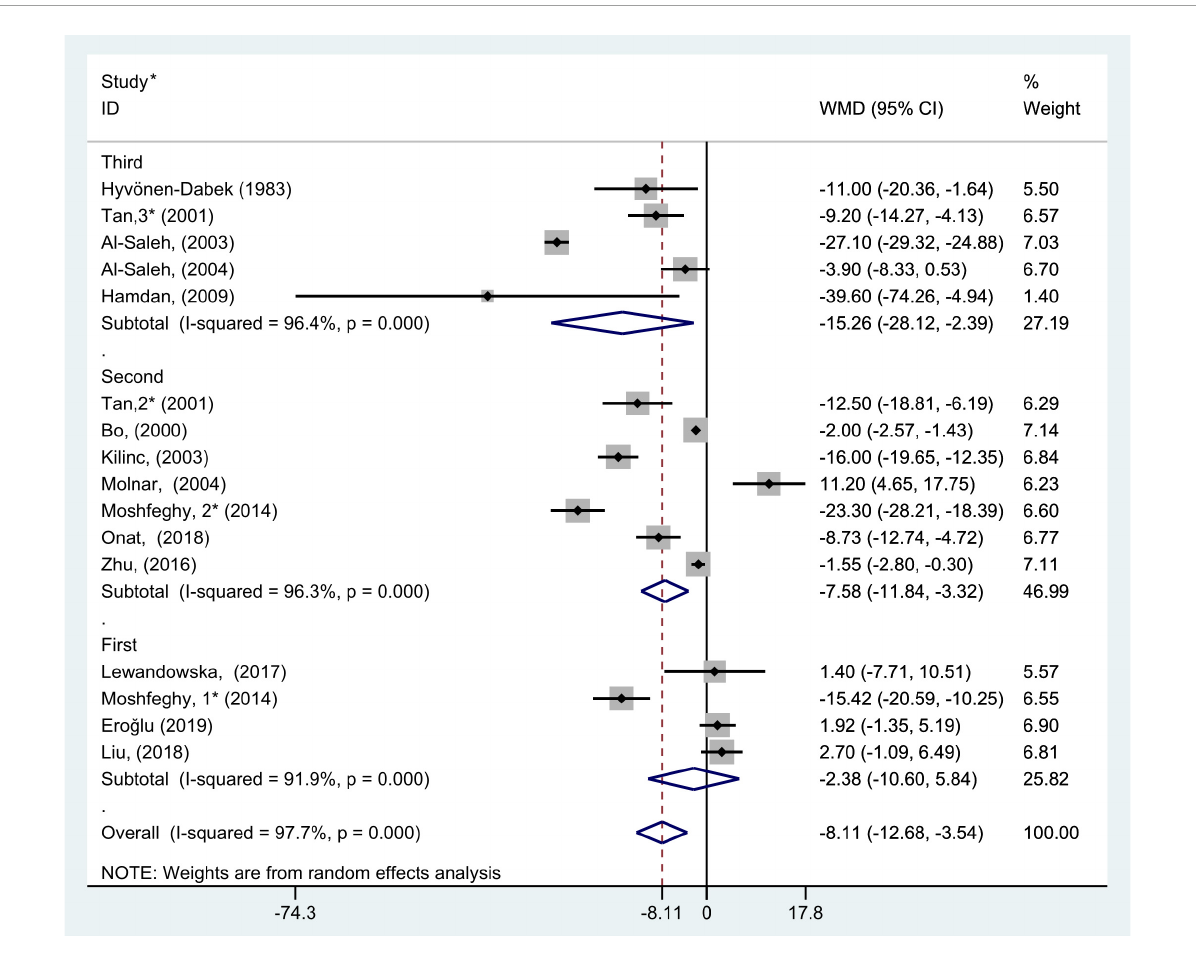
FIGURE4 Subgroup analysis of blood selenium level in patients with gestational diabetes mellitus and healthy pregnant women based on different trimesters. The random effects model is applied. For studies in which blood selenium levels were measured during different pregnancy periods in one study, 1, 2, and 3 are used to denote measurements performed in the first, second, and third trimesters, respectively. *First author (year of study